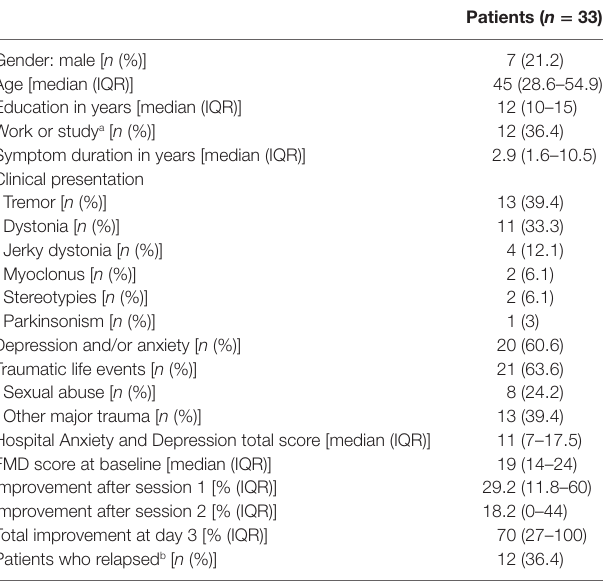
TaBle 1 | Description of the patients.